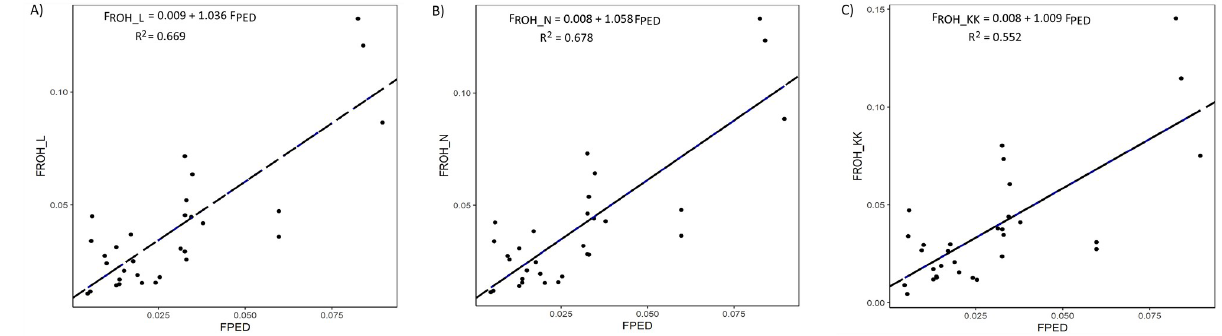
Fig 2. Regression plot of A) F ROH_L on F PED , (B) F ROH_N on F PED , and (C) F ROH_KK on F PED for 31 German White-headed mutton